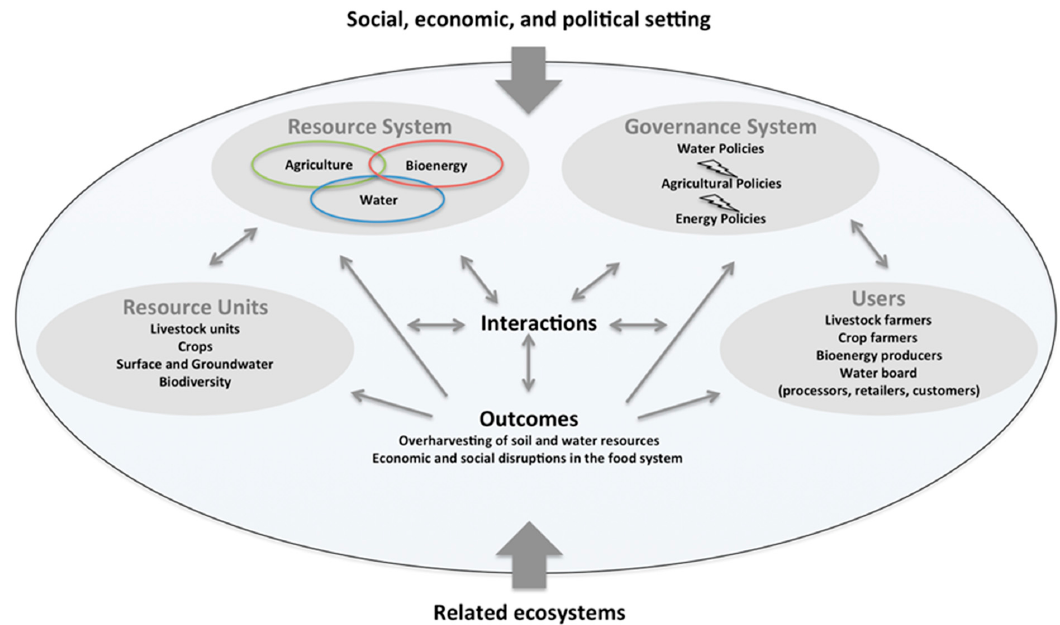
Figure 3. The social-ecological systems framework adapted for the Water–Energy–Food Nexus in the Cloppenburg and Vechta region. Source: own compilation based on Ostrom [12] and the results of the empirical analysis